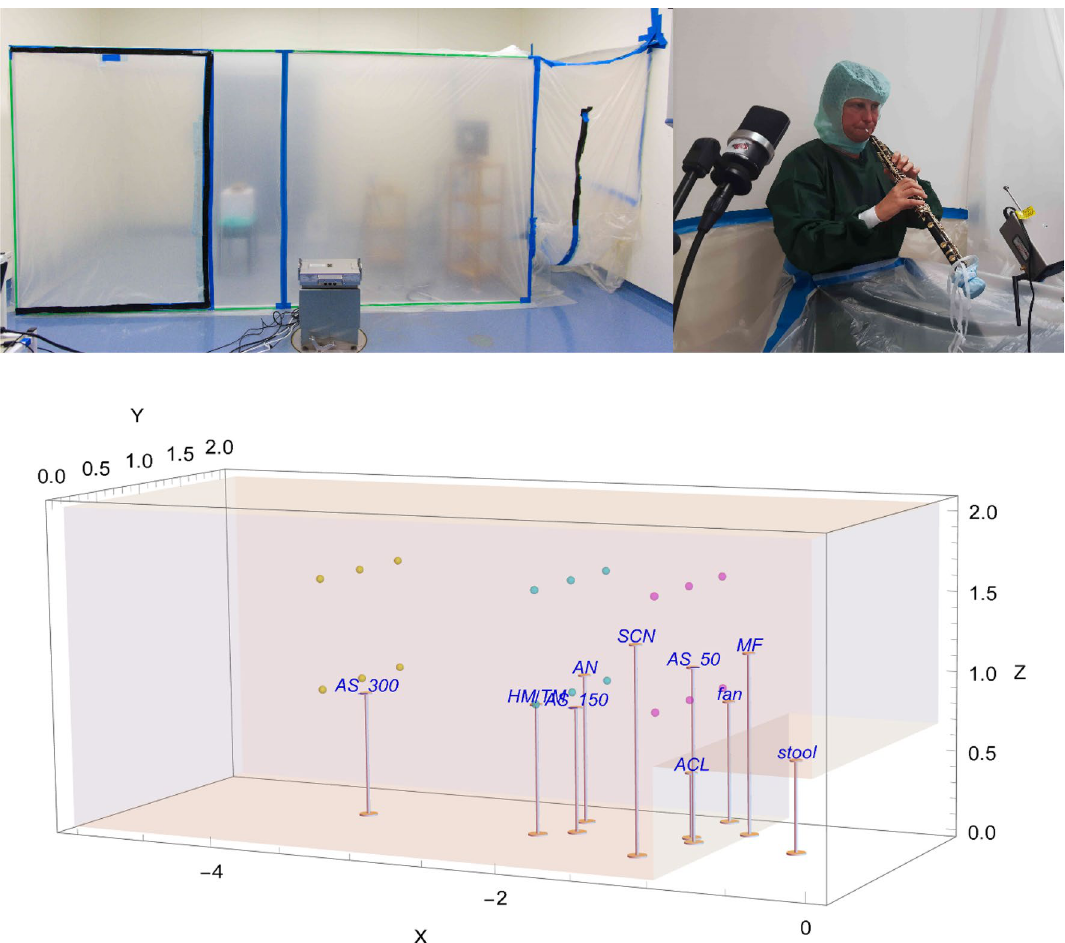
Figure 1. Photographs (top) and 3D-figure (bottom) of the experimental setup. Black tape on the probe chamber’s foil indicates the left and right opening slots allowing air exchange between successive measurements. Air flow measurement points are marked as coloured dots. Average room temperature was 24.0 ± 0.3 °C; average relative humidity was 42 ± 5% for flutists and 40 ± 6% for oboists. Air velocity never exceeded 0.01 m/s at the anemometer position. AS aerosol spectrometer, AN anemometer, HM/TM hygrometer/thermometer, MF microphone, SCN screen, ACL air cleaner, scales in m. The oboist gave her informed consent to publication of the photograph (right).